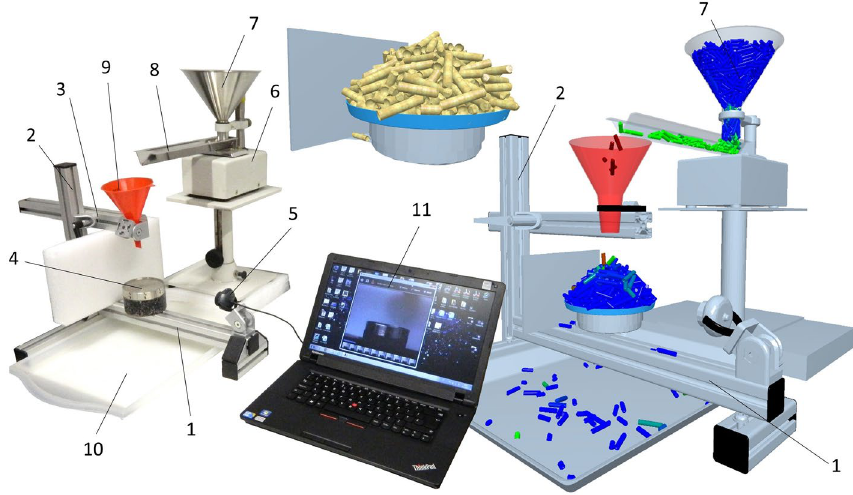
Figure 4. Schematic representation of Zenegero device to determine static angle of repose 1—device frame, 2—column profile to adjust shoulder height, 3—shoulder, 4—circular cell, 5—camera, 6—vibrating feeder, 7—filling funnel, 8—transport trough, 9—routing funnel, 10—collecting tray for excess material, 11—PC with